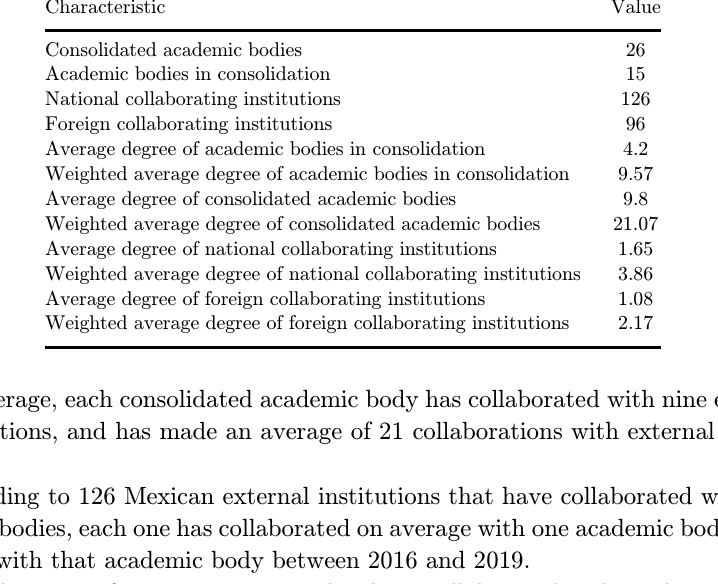
Table 5. Statistics for the characteristics in the graph of collaboration of academic bodies.